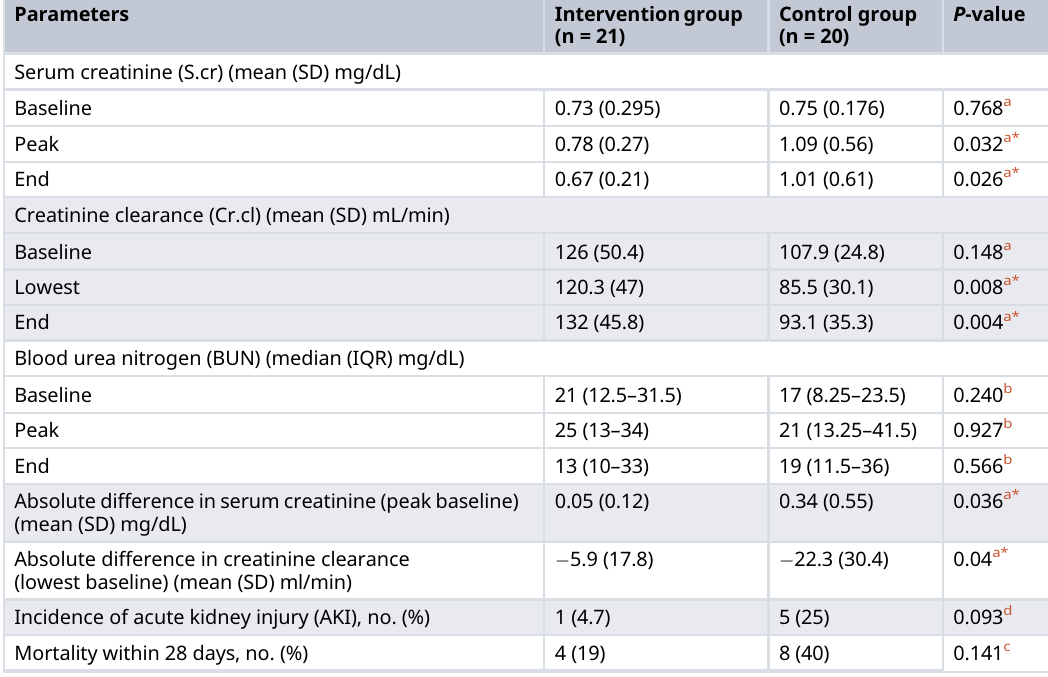
Table 2. Differences in laboratory investigations and mortality between the study groups.